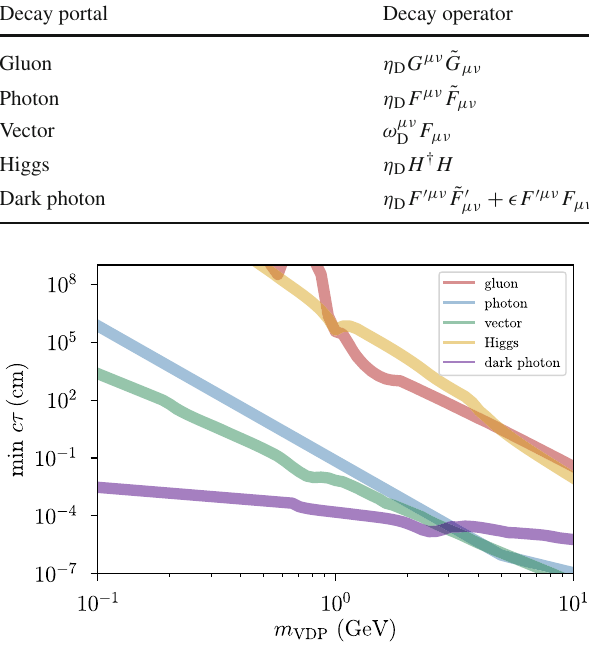
Fig. 8 Approximate lower bound on the proper lifetime of the visibly decaying particle (VDP) in the dark sector, for the decay portals in Table 1 sidered with a single (pseudo)scalar η D and vector ω D